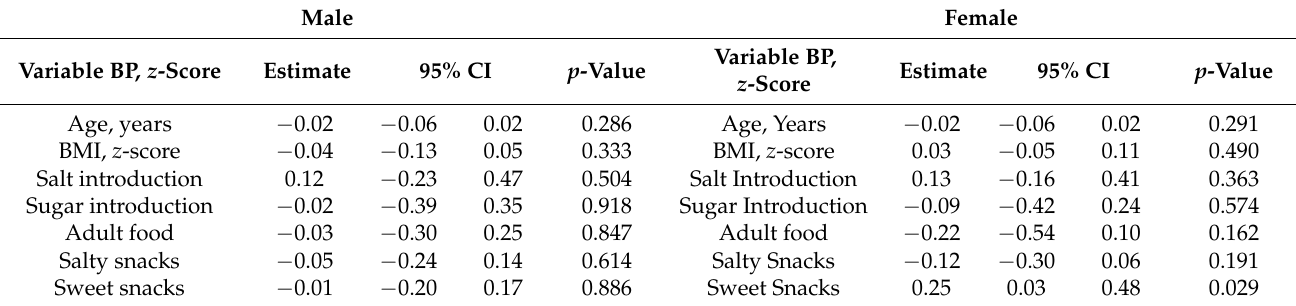
Table 4. Multivariable linear regression models on the relationship between blood pressure ( z -score) and possibly correlated variables in groups defined by gender. Male